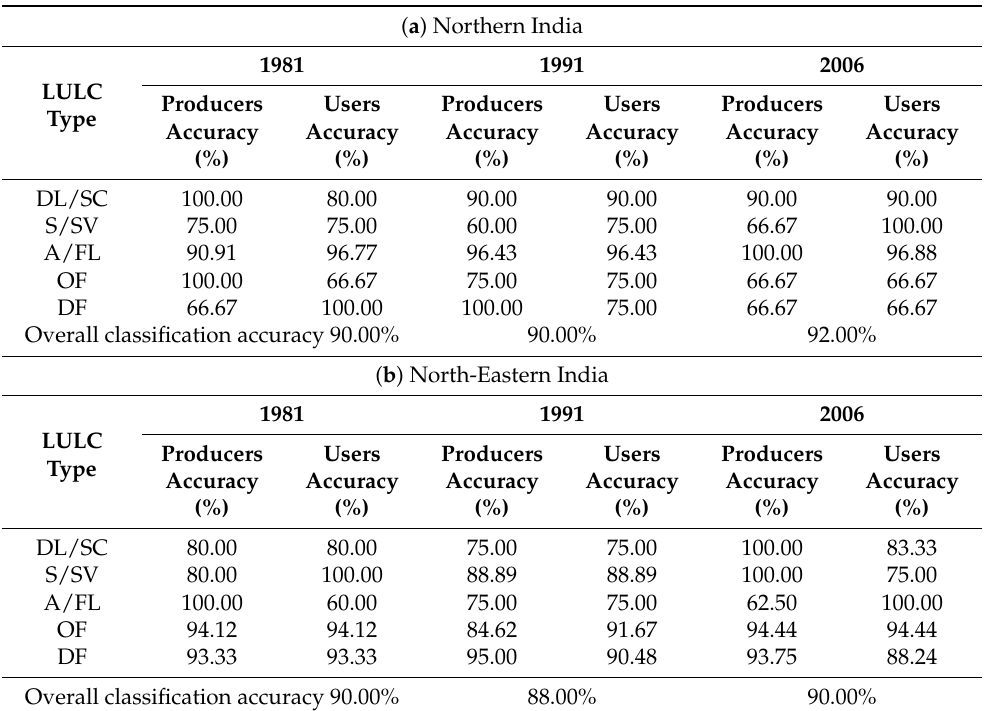
Table 2. Accuracy assessment of LULC types for 1981, 1991 and 2006; ( a ) Northern India, ( b ) North- Eastern